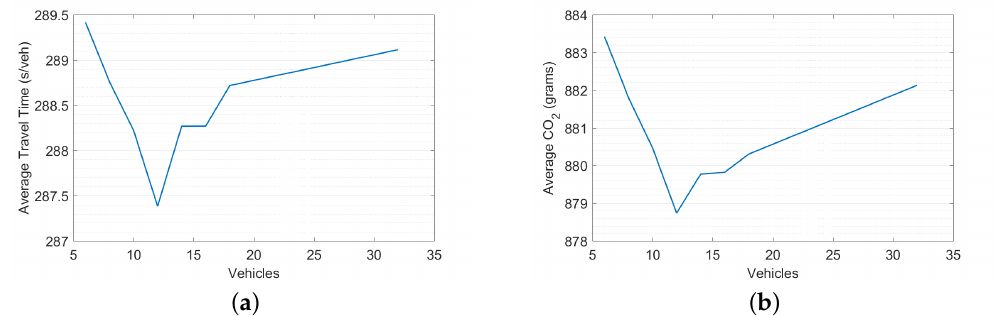
Figure 6. Sensitivity analysis. ( a ) Average travel time. ( b ) Average CO 2